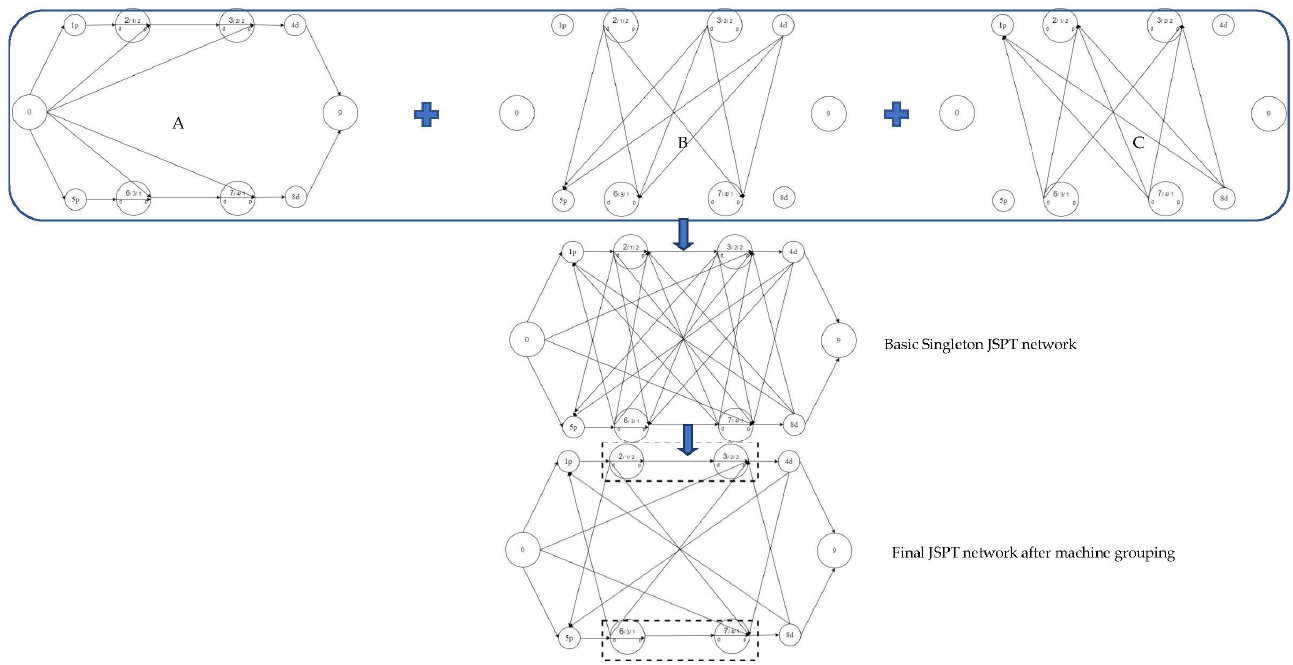
Figure 4. JSPT network constructed from FJSP + T machine-operation assignments. ( A ) comprises O-p arcs, d-E arcs for transporter conservation, intramachine d-p arcs to mirror waiting of transporters at respective stations, and intermachine p-d arcs within each job to mirror transportation of jobs (load fl ows). ( B , C ) comprise d-p arcs to mirror empty transporters traveling to pick up other jobs after depositing their respective jobs (transporter fl ows).